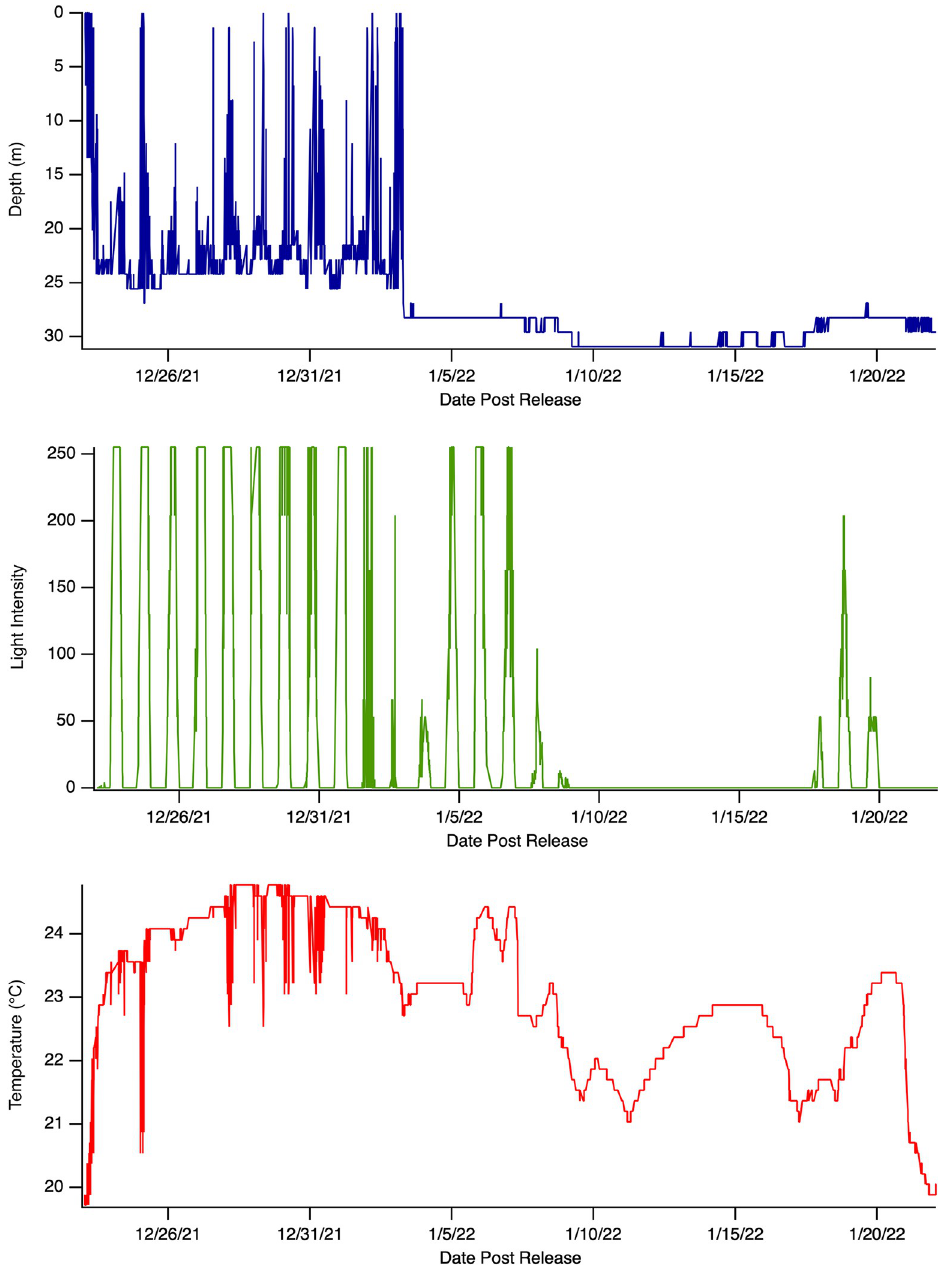
Fig 5. Example of PSAT tag data from a blacktip shark (C_lim05). This individual survived the tagging process and exhibited normal oscillatory diving behavior for 10 days following release. The tag then registers a constant depth at ~30m for five full days, suggesting a natural mortality event occurred, before fluctuating between 28-31m for two weeks and finally releasing at its programmed interval. This tag was not pre-programmed to release when constant depth was detected. This individual was ultimately considered a natural mortality and was not included in the overall PRM rate estimate. Given the normal diving behavior for > 10 days in all instances, recovery from the tagging event is indicated, suggesting these sharks all survived the direct physical damage and physio- logical stress of capture and release. If the subsequent lack of depth variation in these cases was